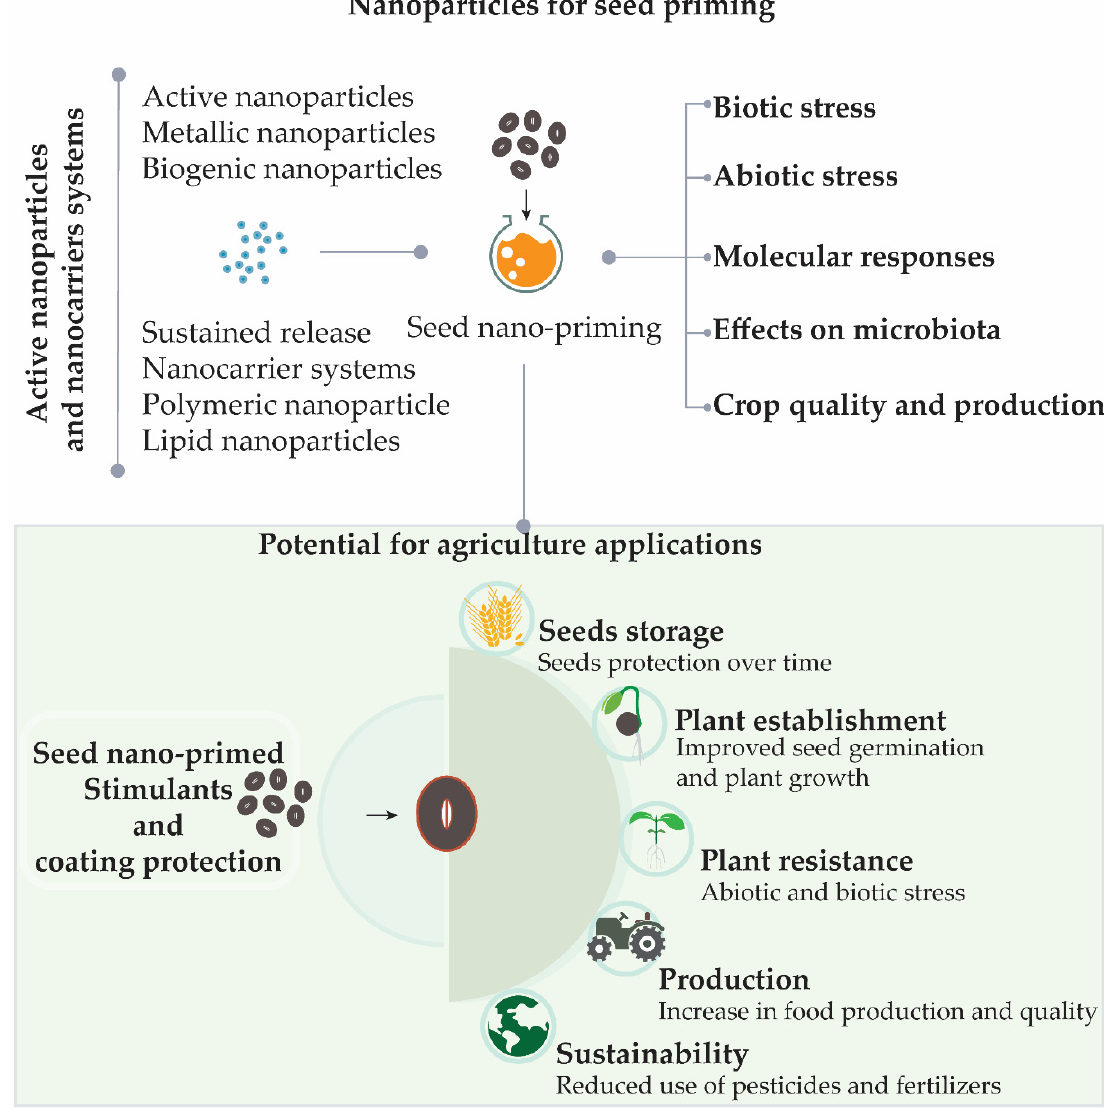
Figure 1. Seed nano-priming topics covered in this review and its potential benefits for sustainable agriculture. In addition to providing protection for seeds during storage, the use of seed nano-priming can result in improved establishment of plants in the soil with a reduced need for fertilizers. By growing faster, plants have an increased ability to compete with weeds for resources, consequently increasing productivity and food quality. The plants may also become more resistant to abiotic and biotic stresses, resulting in reduced use of pesticides.